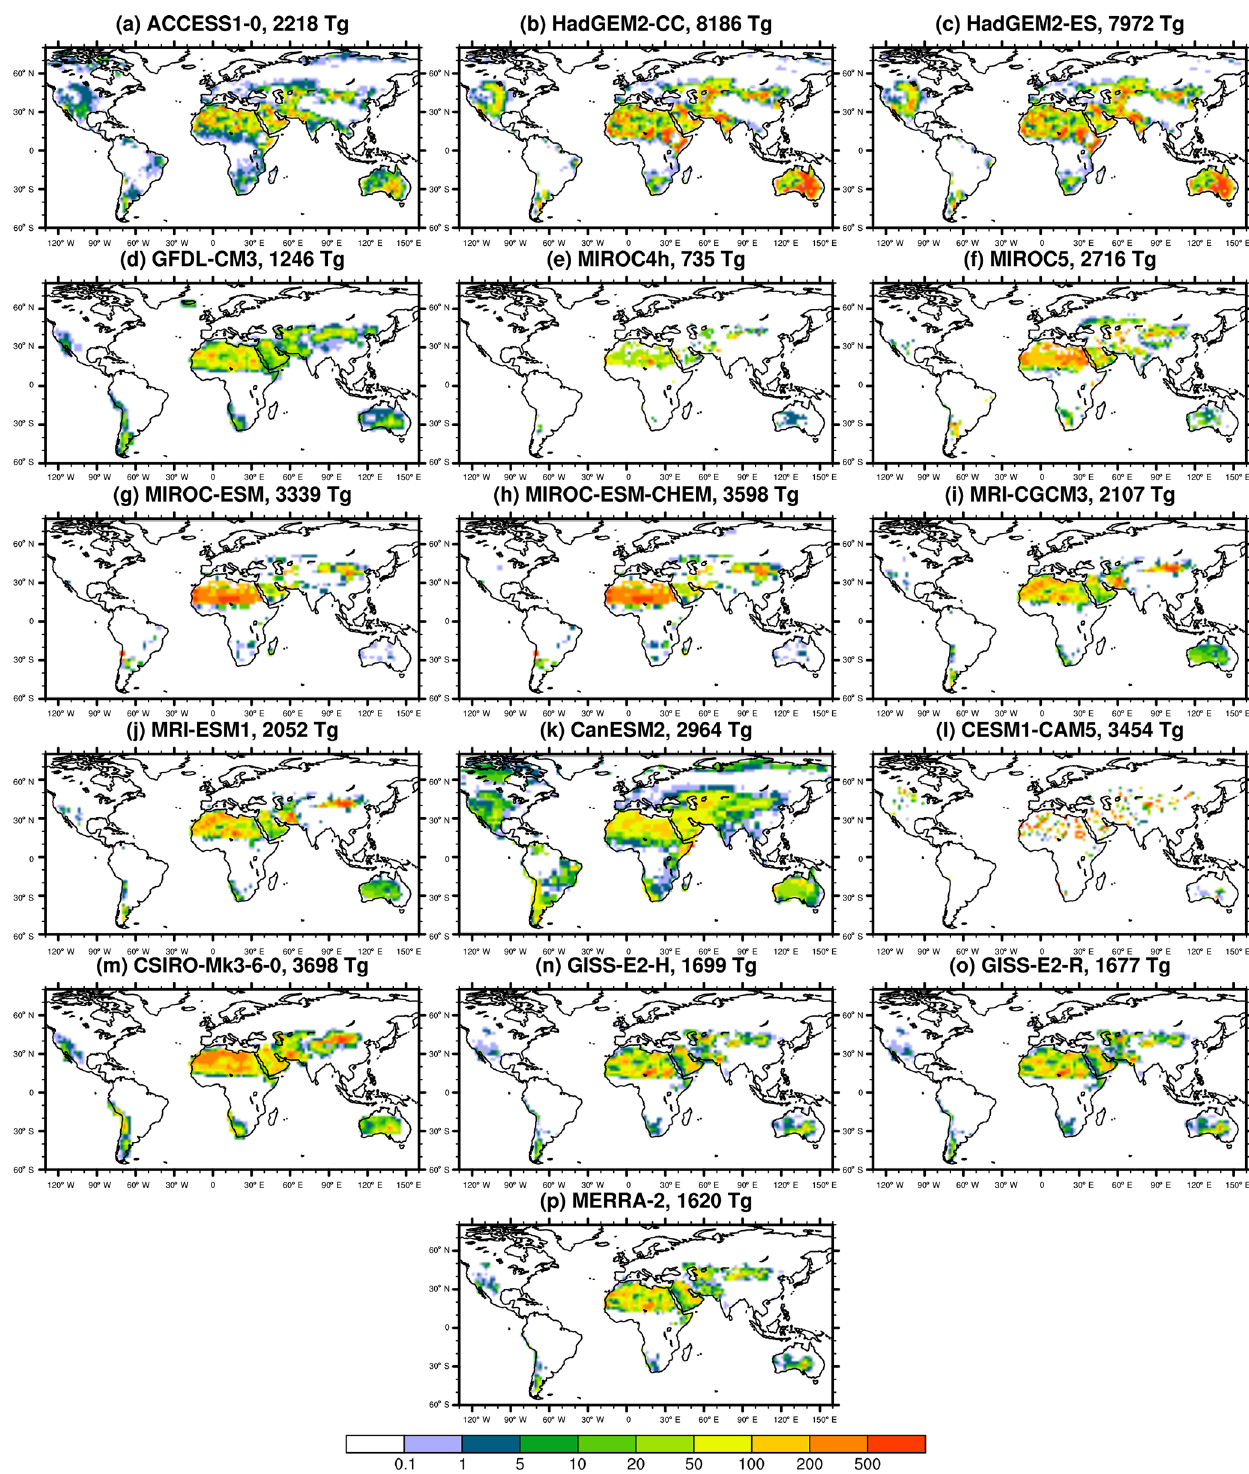
Figure 3. (a–o) Annual mean dust emission flux (gm − 2 yr − 1 ) during 1960–2005 from 15 CMIP5 models and (p) annual mean dust emission (gm − 2 yr − 1 ) during 1980–2018 from the MERRA-2 reanalysis. The total annual global dust emission is included in the title of each